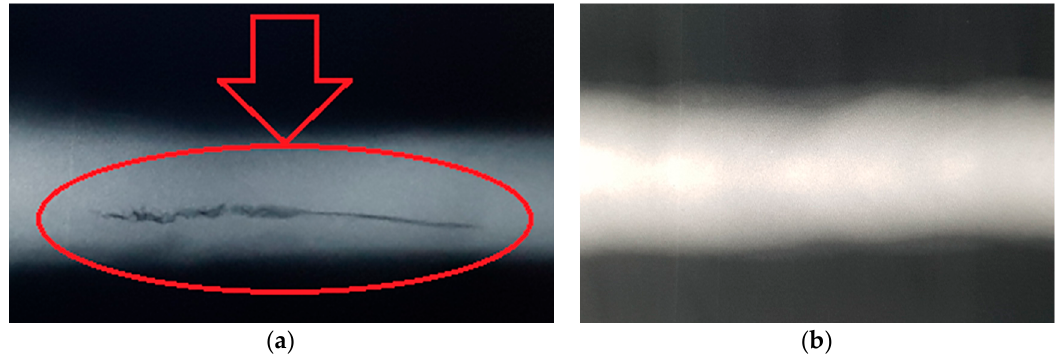
Figure 4. Weld after welding without ( a ) and with ( b ) micro-jet cooling in X-ray inspection.